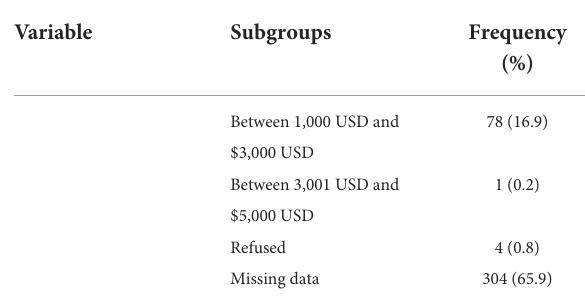
TABLE 1 Social and demographic characteristics of respondents.